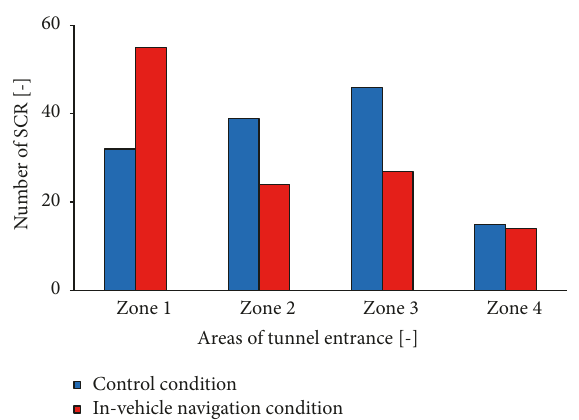
Figure7:ComparisonsoftheamplitudeofSCRbetweenthecontrol condition and in-vehicle navigation